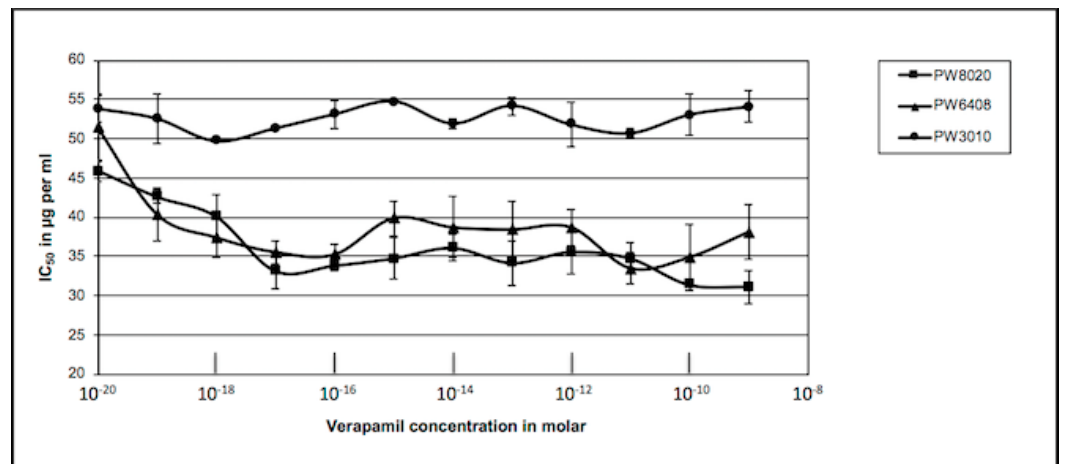
Figure 2. Effects of verapamil on sensitivity of several PAO1 mutants to carbenicillin. P. aeruginosa PAO1 mutants Pseudomonas Washington (PW) mutant PW3010, PW6408, and PW8020 were